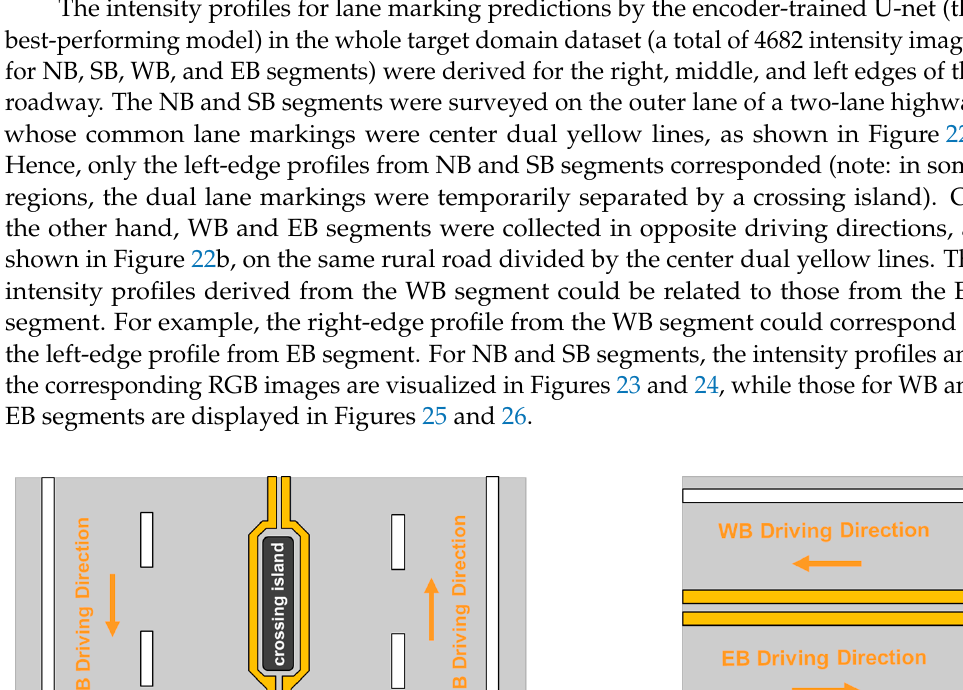
Figure 22. Road delineation of ( a ) NB and SB segments and ( b ) WB and EB